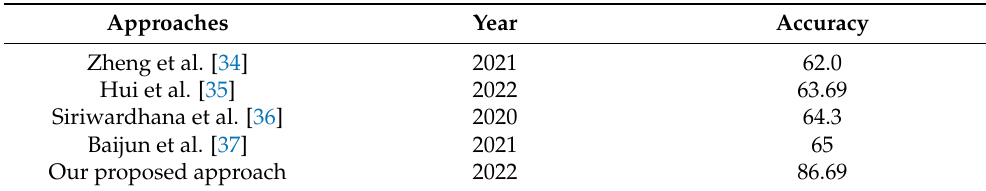
Table 6. A brief comparison of our proposed approach with other related works in the function of Accuracy (unit = %).